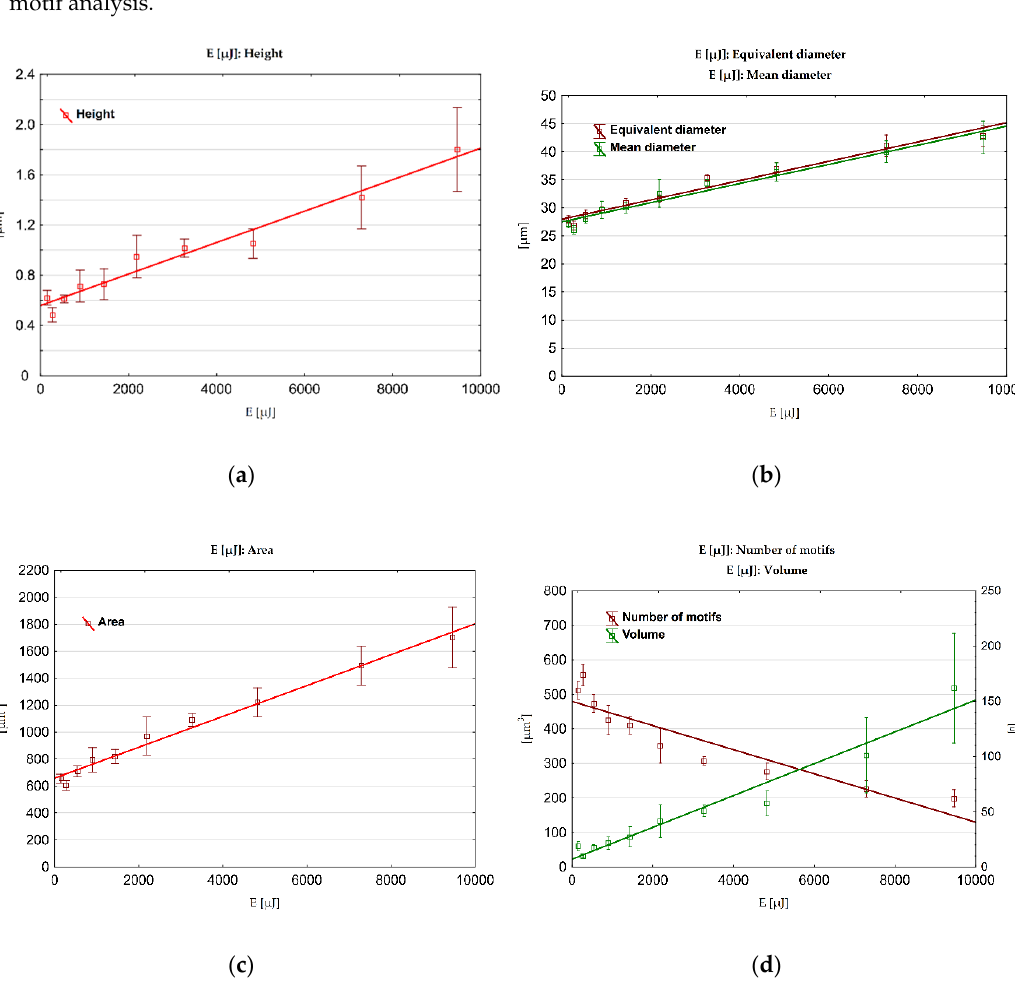
Figure 8. Scatter plots for motif analysis: ( a ) mean height; ( b ) equivalent and mean diameter; ( c ) mean area; ( d ) mean volume and number of motifs correlated with discharge energies using linear regression.